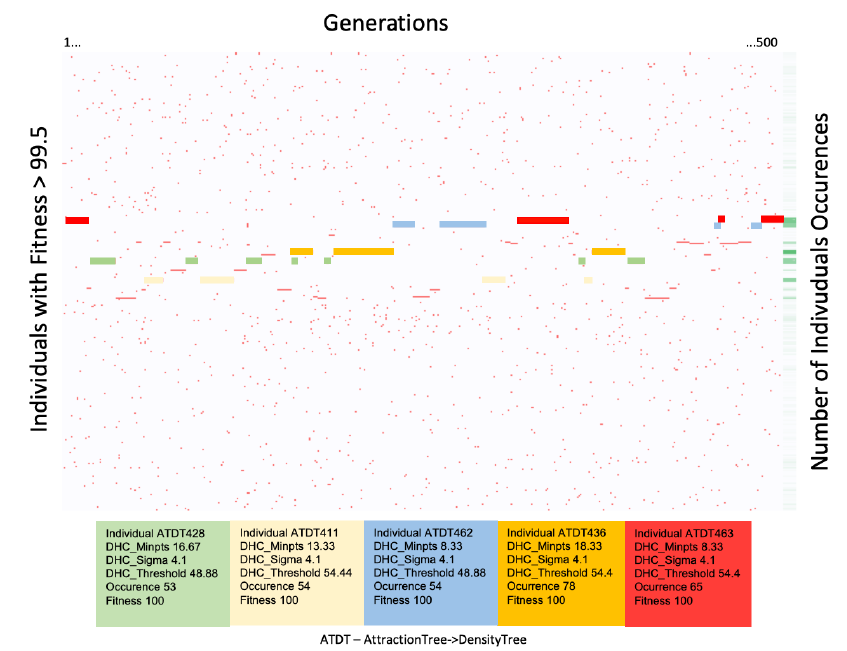
Figure 5. Visualization to track the best individuals in a